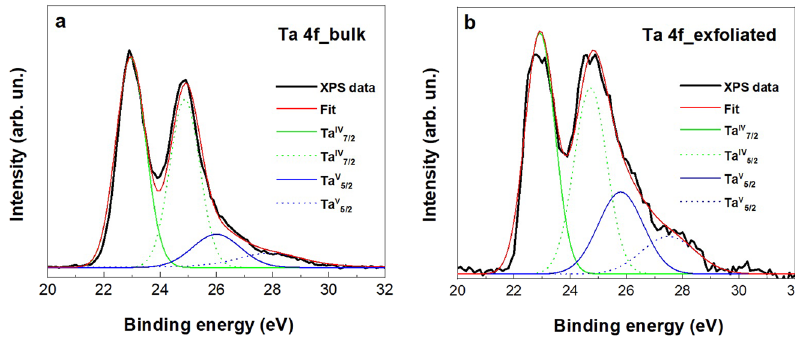
Fig. 6 Chemical composition and binding states of TaS 2 . High-resolution XPS spectra of the a bulk and b electrochemically exfoliated TaS 2 nanostructures.